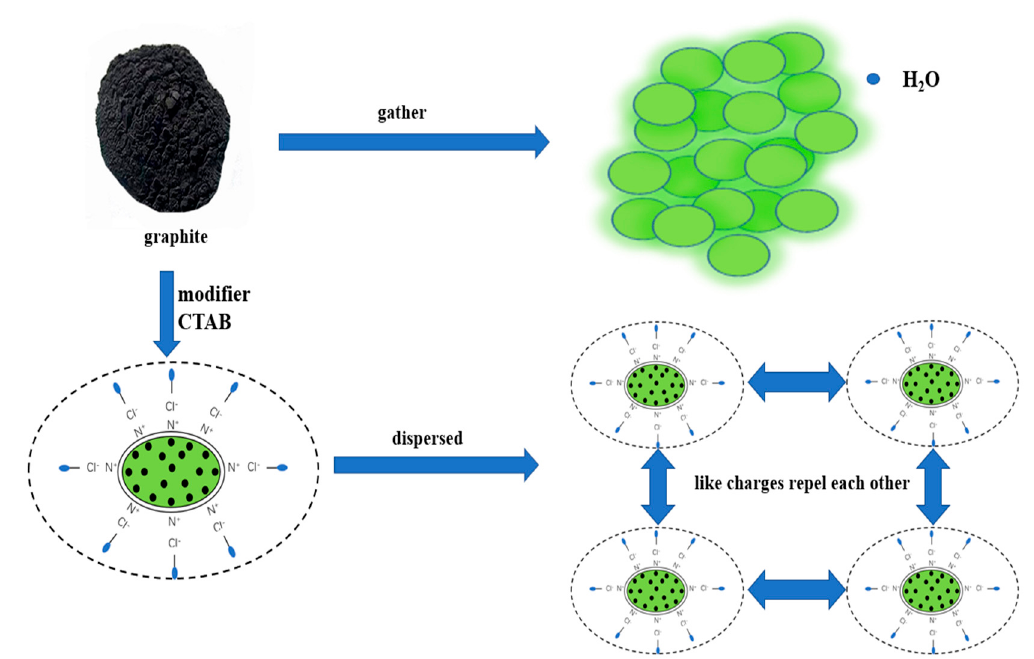
Figure 8. Mechanism of adsorption and dispersion of graphite.